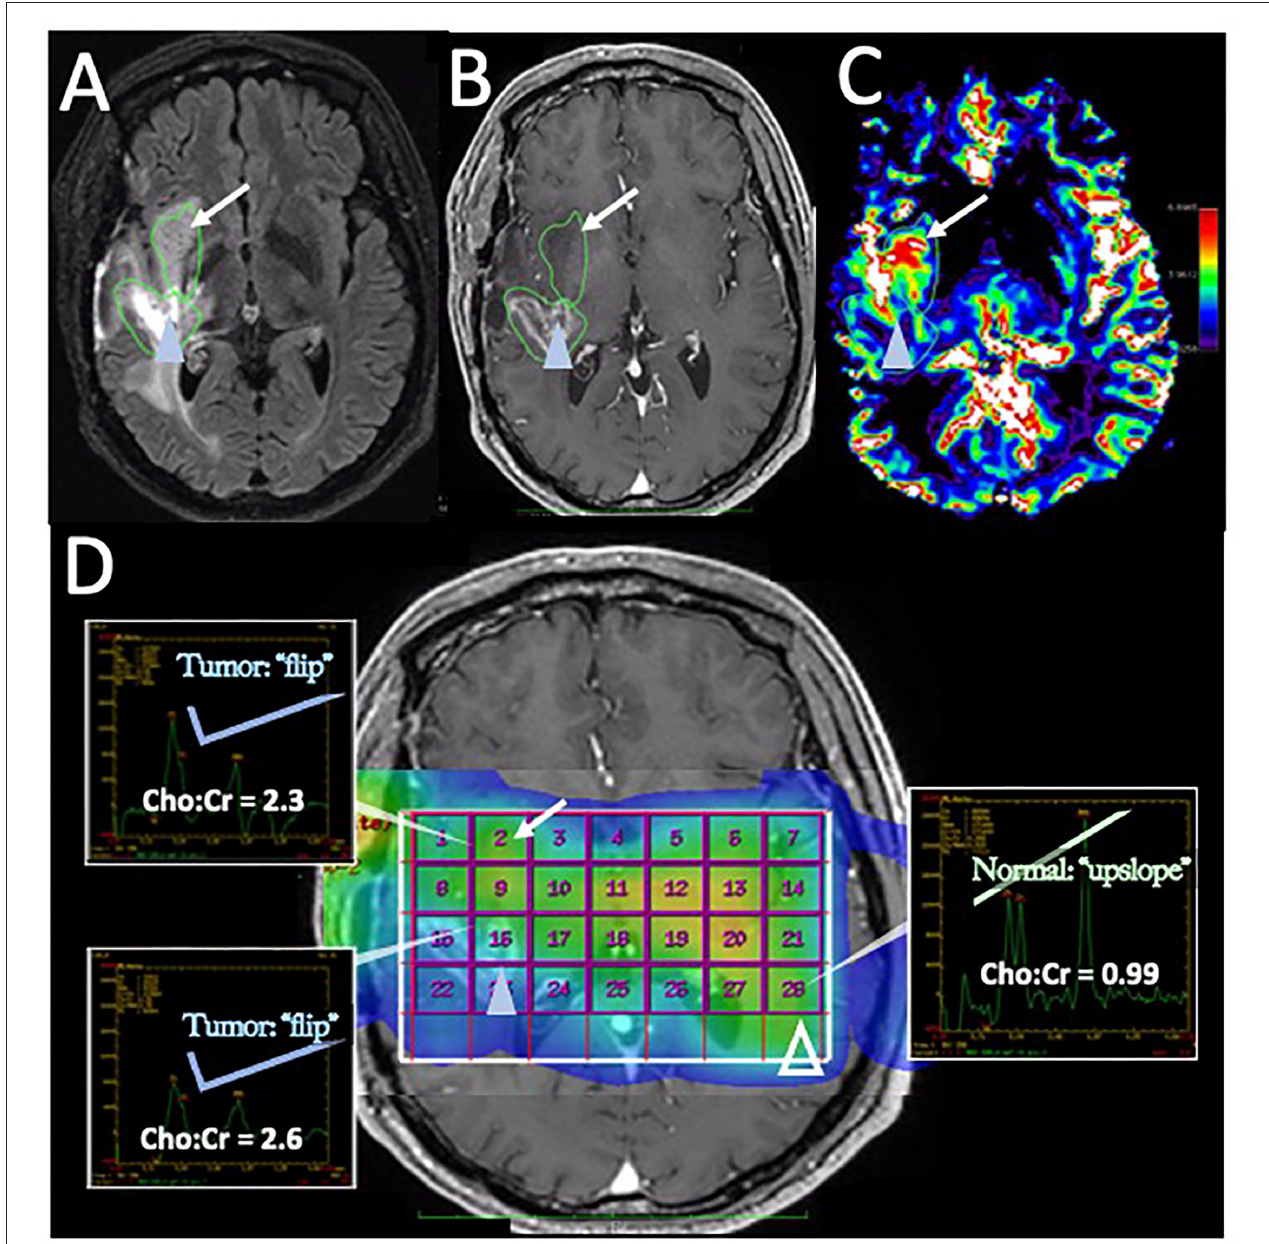
FIGURE 5 | Disease recurrence on DSC-MRI and MRS: A 50-year-old man with right temporal WHO grade III anaplastic oligodendroglioma status post three surgical resections, radiation therapy, and chemotherapy with temozolomide, procarbazine, and lomustine was found to have signs of recurrence on surveillance CE-MRI. (A) Axial FLAIR image superior to the resection cavity shows prominent increased FLAIR signal posteriorly (blue arrowhead) and less intense, but more rounded FLAIR signal anteriorly (arrow). (B) Axial post-contrast T1-weighted image demonstrates heterogenous enhancement of the posterior region (blue arrowhead) with no significant enhancement in the anterior region (arrow) (C) The DSC rCBV map shows increased perfusion of the anterior nonenhancing/FLAIR hyperintense region (arrow) but heterogeneous areas of both increased and decreased perfusion in the enhancing posterior region (arrowhead). (D) Magnetic resonance spectroscopy (MRS) demonstrates elevated Cho:Cr ratios in both the anterior nonenhancing (arrow, ratio = 2.3) and the posterior enhancing (solid blue arrowhead, ratio = 2.6) regions. Normal ratios are shown on the contralateral brain (open arrowhead, Cho:Cr ratio = 0.99) for comparison, showing the normal upslope vs. the “Cho-to-Cr flip” seen with the tumor. Both sites with elevated Cho:Cr ratio was concerning for disease progression. The heterogeneous rCBV of the posterior enhancing region was attributed to a combination of disease recurrence and necrotic change. The patient was treated with repeat proton-beam radiation and temozolomide with improvement in the enhancement and FLAIR signal abnormality on subsequent MRI (not